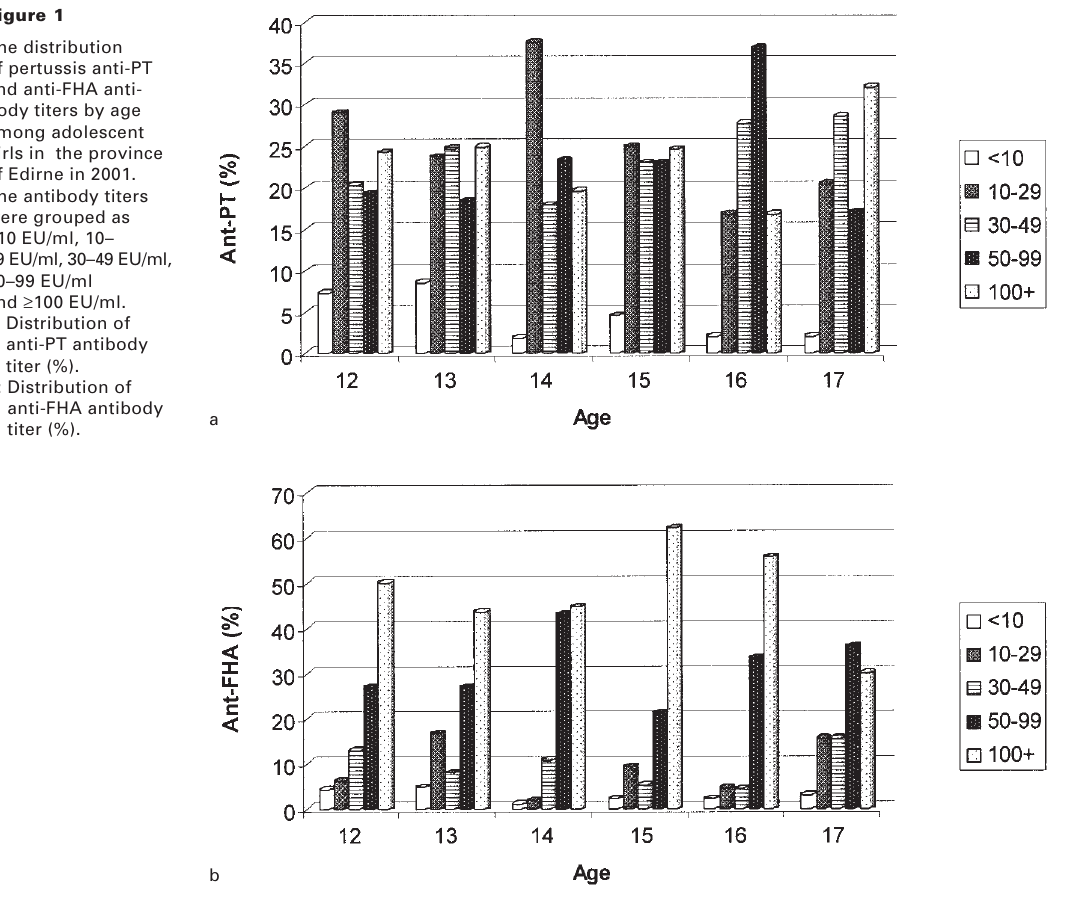
The distribution of pertussis anti-PT and anti-FHA anti- body titers by age among adolescent girls in the province of Edirne in 2001. The antibody titers were grouped as <10 EU/ml, 10–